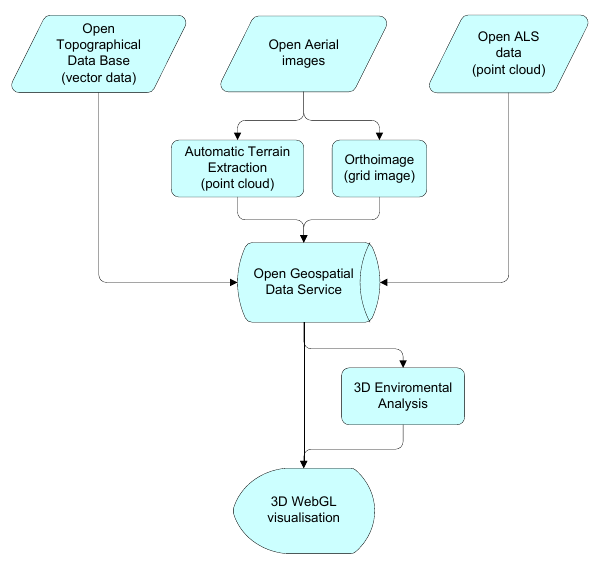
Figure 1: General flow chart of the proposed method. The process starts with collection and pre-processing of the available open geospatial data. The pre-processed data is distributed via open standard interface services. 3D data analyses are processed on-demand either on web server or with desktop software. The data and results from analysis step are then visualized in standard web browser using 3D